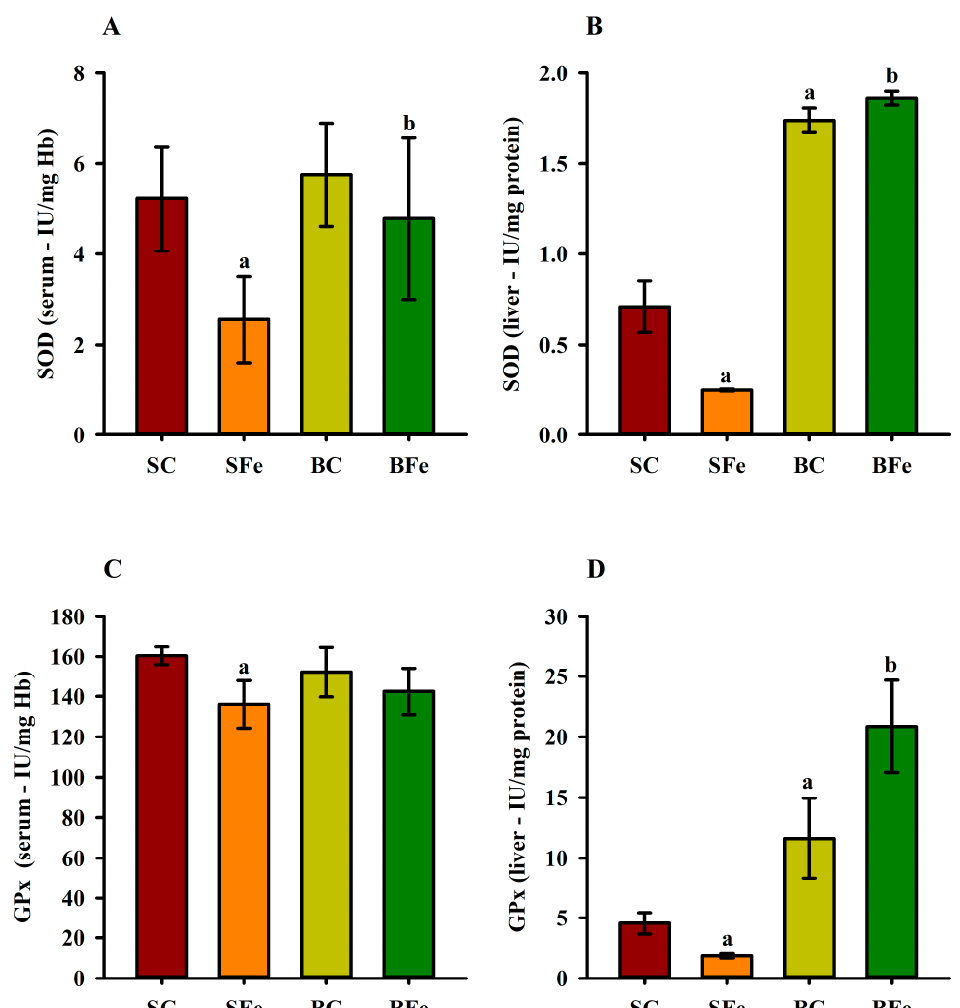
Figure 5. Serum and hepatic superoxide dismutase ( A , B ) and glutathione peroxidase ( C , D ) activities in rats treated or not with a high dose of FeSO 4 and diets added with either soybean oil or buriti oil. GPx = glutathione peroxidase; SOD = superoxide dismutase. a Represents a significant difference compared with the SC; b Represents a significant difference compared with the SFe. Values in the vertical bars are mean ± SD of each rat group (Student’s t -test, p ≤ 0.05; n = 8 rats/group).